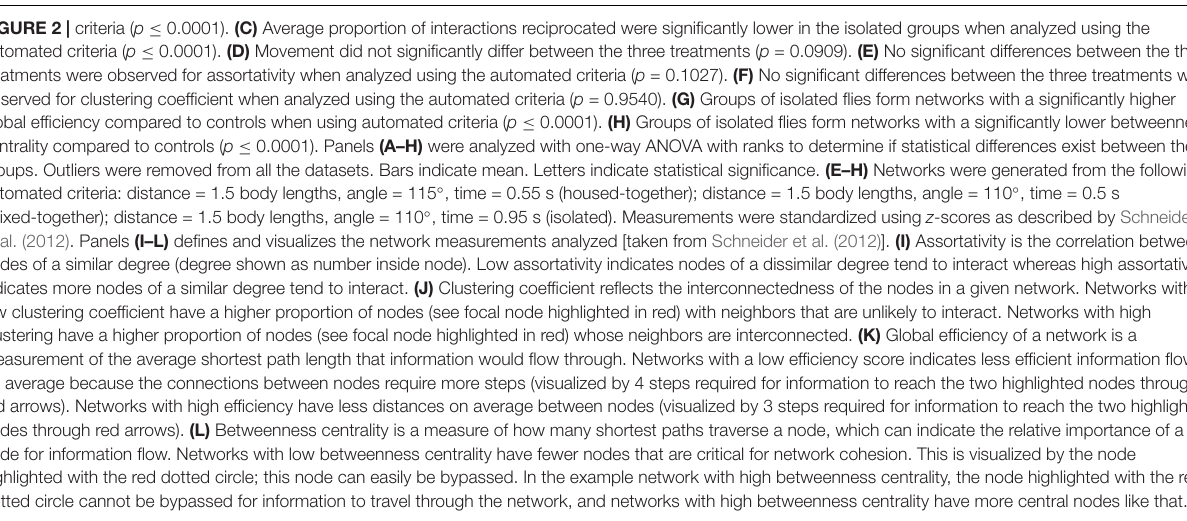
FIGURE 2 | criteria ( p ≤ 0.0001). (C) Average proportion of interactions reciprocated were significantly lower in the isolated groups when analyzed using the automated criteria ( p ≤ 0.0001). (D) Movement did not significantly differ between the three treatments ( p = 0.0909). (E) No significant differences between the three treatments were observed for assortativity when analyzed using the automated criteria ( p = 0.1027). (F) No significant differences between the three treatments were observed for clustering coefficient when analyzed using the automated criteria ( p = 0.9540). (G) Groups of isolated flies form networks with a significantly higher global efficiency compared to controls when using automated criteria ( p ≤ 0.0001). (H) Groups of isolated flies form networks with a significantly lower betweenness centrality compared to controls ( p ≤ 0.0001). Panels (A–H) were analyzed with one-way ANOVA with ranks to determine if statistical differences exist between the groups. Outliers were removed from all the datasets. Bars indicate mean. Letters indicate statistical significance. (E–H) Networks were generated from the following automated criteria: distance = 1.5 body lengths, angle = 115 ◦ , time = 0.55 s (housed-together); distance = 1.5 body lengths, angle = 110 ◦ , time = 0.5 s (mixed-together); distance = 1.5 body lengths, angle = 110 ◦ , time = 0.95 s (isolated). Measurements were standardized using z -scores as described by Schneider et al. (2012). Panels (I–L) defines and visualizes the network measurements analyzed [taken from Schneider et al. (2012)]. (I) Assortativity is the correlation between nodes of a similar degree (degree shown as number inside node). Low assortativity indicates nodes of a dissimilar degree tend to interact whereas high assortativity indicates more nodes of a similar degree tend to interact. (J) Clustering coefficient reflects the interconnectedness of the nodes in a given network. Networks with low clustering coefficient have a higher proportion of nodes (see focal node highlighted in red) with neighbors that are unlikely to interact. Networks with high clustering have a higher proportion of nodes (see focal node highlighted in red) whose neighbors are interconnected. (K) Global efficiency of a network is a measurement of the average shortest path length that information would flow through. Networks with a low efficiency score indicates less efficient information flow on average because the connections between nodes require more steps (visualized by 4 steps required for information to reach the two highlighted nodes through red arrows). Networks with high efficiency have less distances on average between nodes (visualized by 3 steps required for information to reach the two highlighted nodes through red arrows). (L) Betweenness centrality is a measure of how many shortest paths traverse a node, which can indicate the relative importance of a node for information flow. Networks with low betweenness centrality have fewer nodes that are critical for network cohesion. This is visualized by the node highlighted with the red dotted circle; this node can easily be bypassed. In the example network with high betweenness centrality, the node highlighted with the red dotted circle cannot be bypassed for information to travel through the network, and networks with high betweenness centrality have more central nodes like